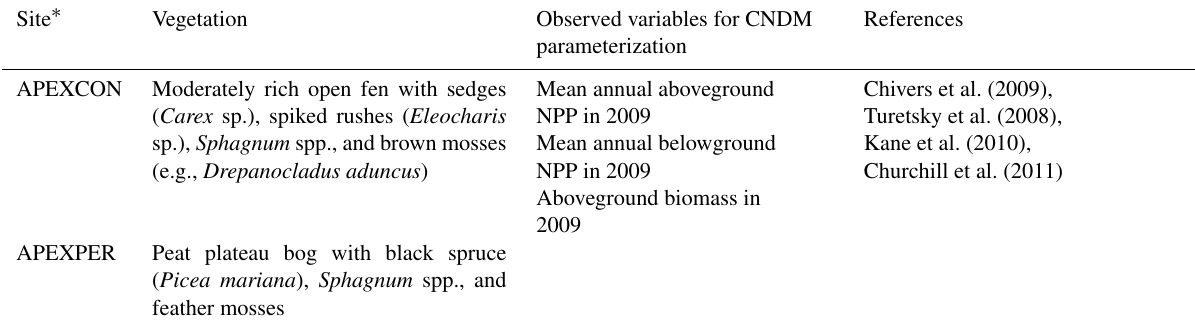
Table 1. Description of sites and variables used for parameterizing the core carbon and nitrogen module